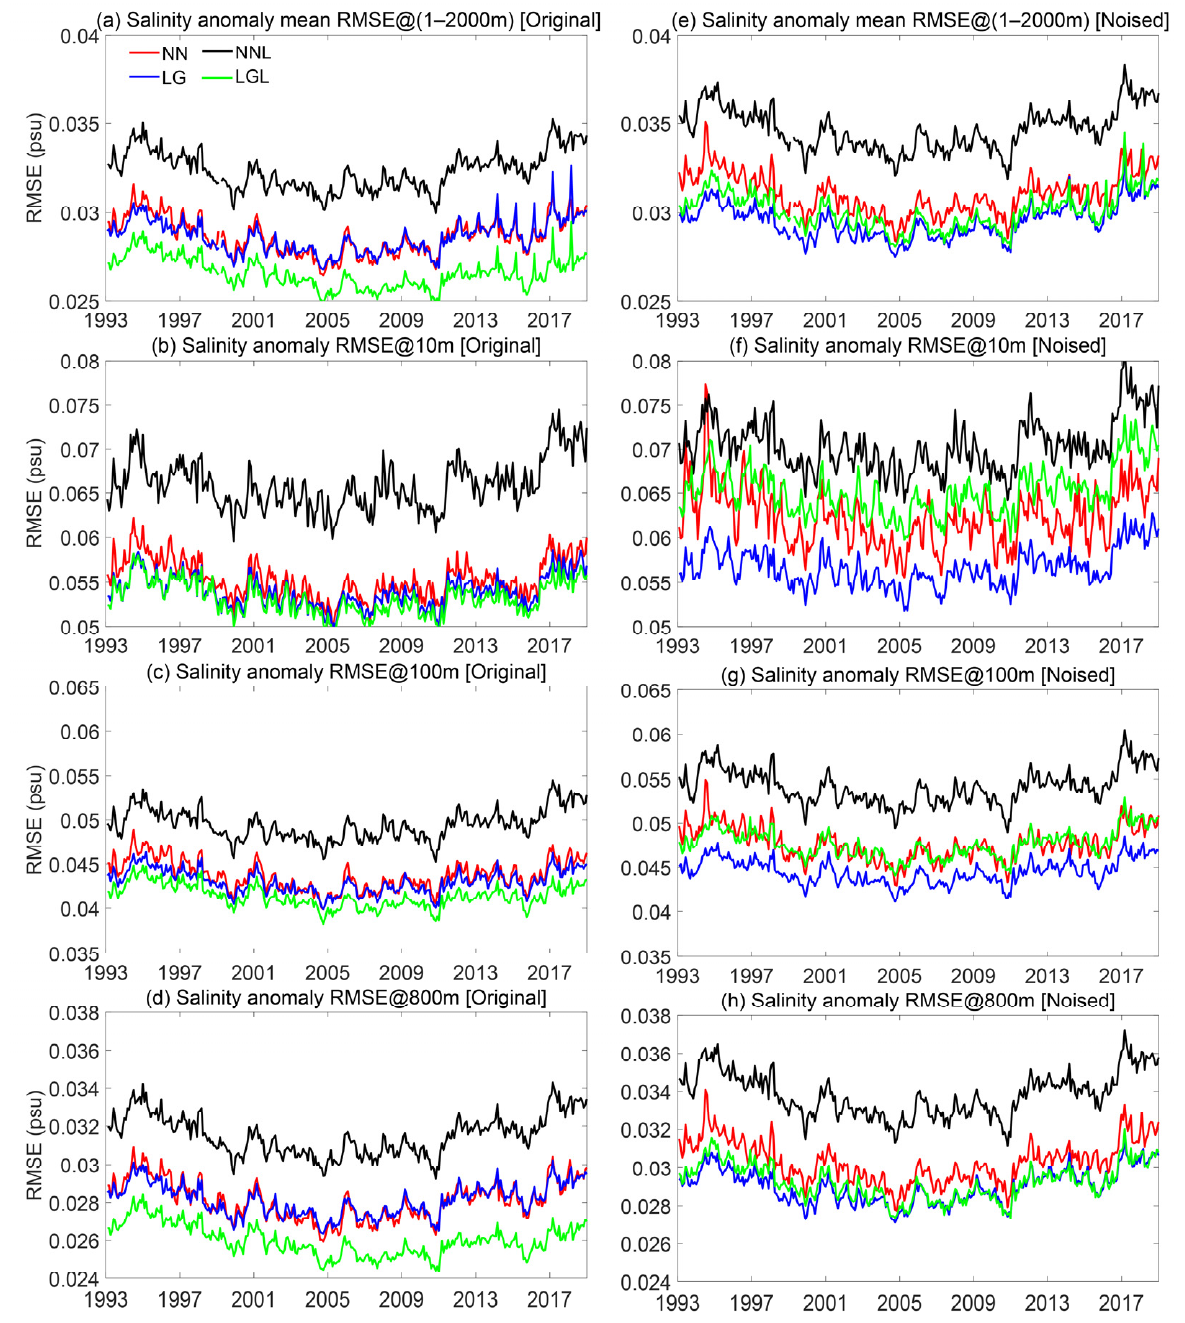
Figure 13. Time series of global average RMSEs in the 1–2000 m depth range and at the three layers. ( a – d ) Experiments performed with the original synthetic dataset. ( e – h ) Experiments performed with the noised synthetic dataset.